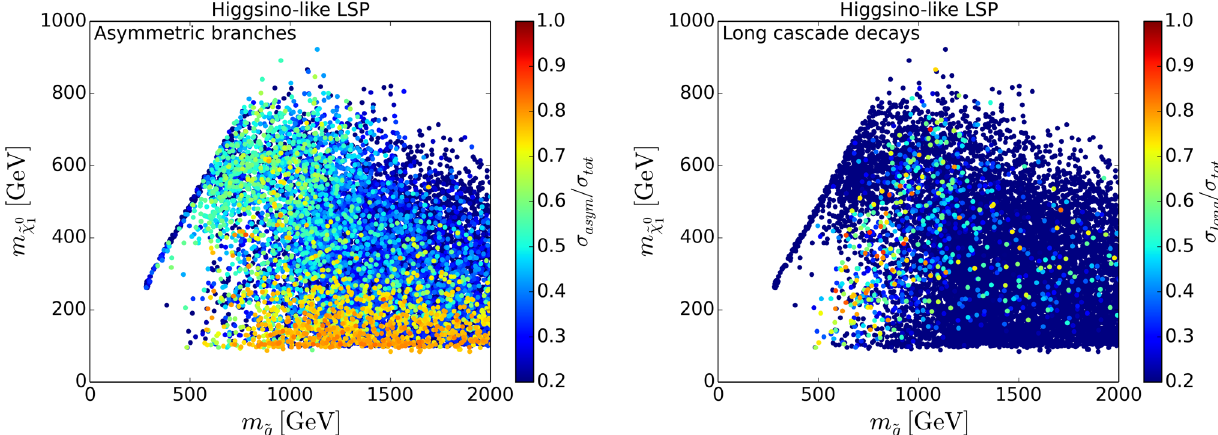
Fig. 5 Same as Fig. 4 but for points with a higgsino-like